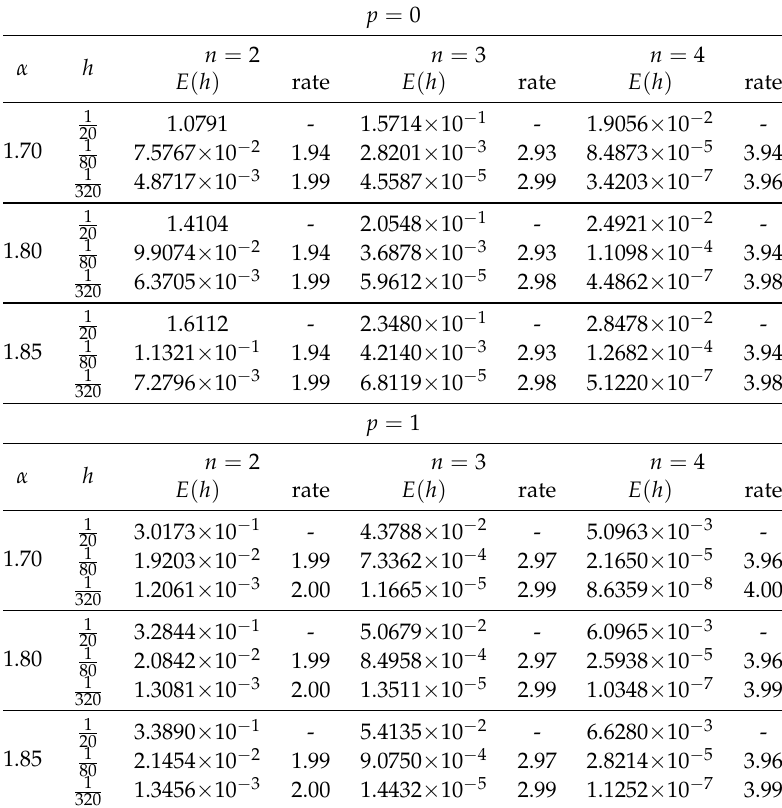
Table 10. The absolute errors and convergence orders of Example 10.